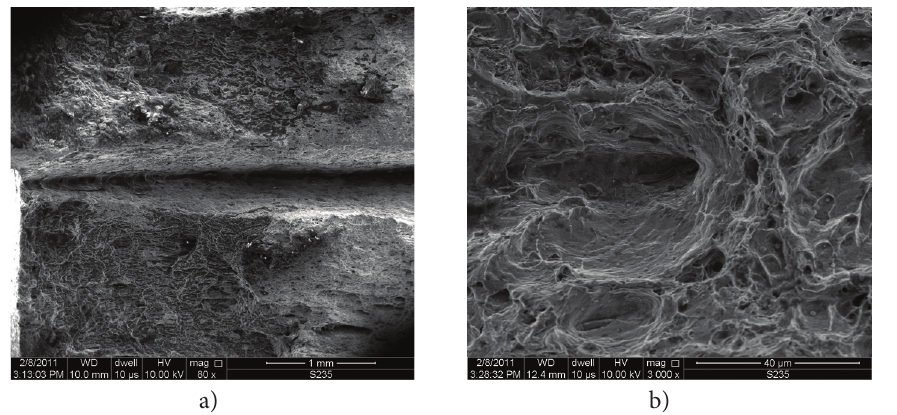
Fig. 7. Microstructure (a), fracture (b) and macrostructure (c) of the railway bridge steel, StM